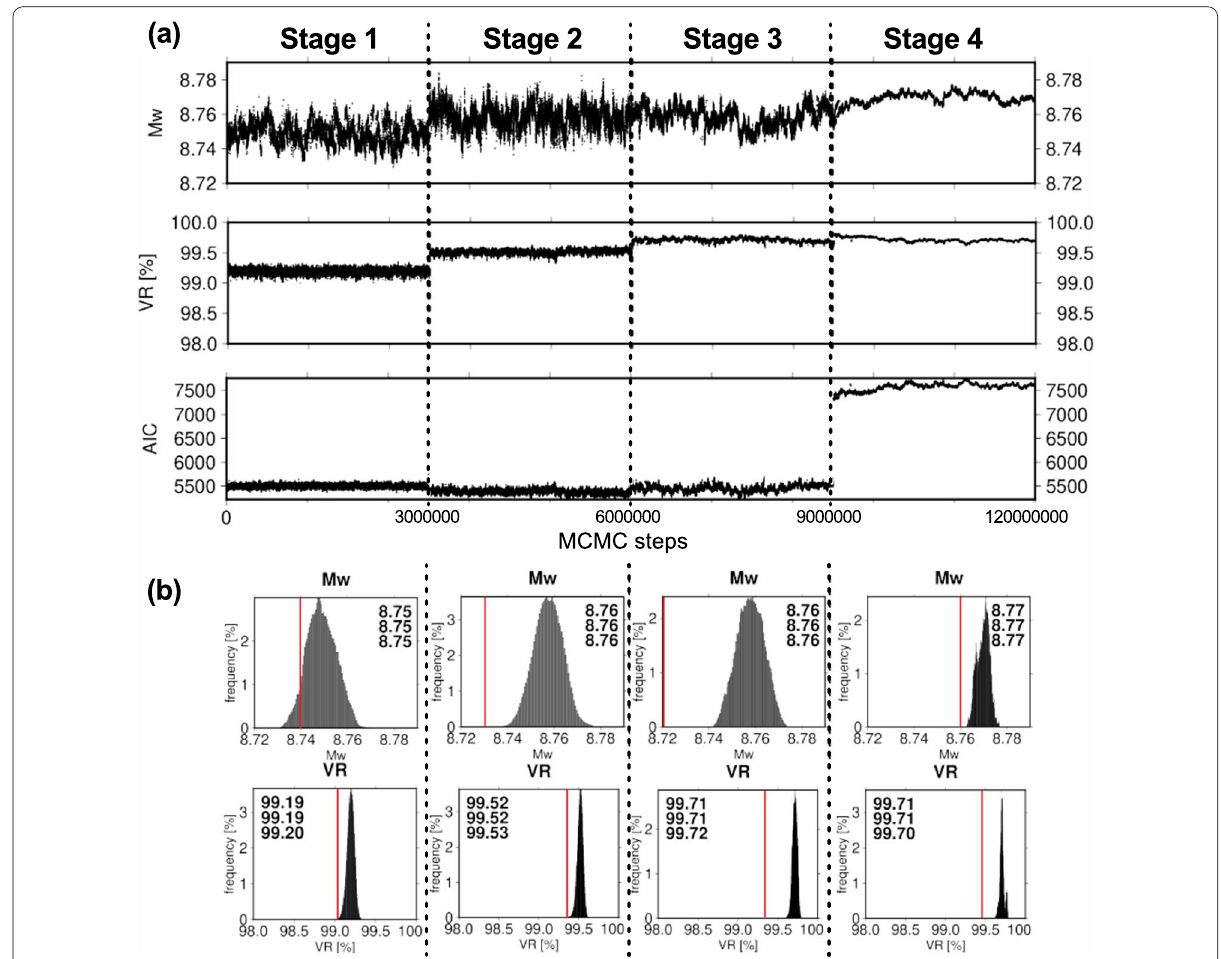
Fig. 5 Markov chains and posterior probability density functions (PDFs). We divided the Markov chain into four stages (number of steps in each chain): stage 1 ( 3 × 10 6 steps); stage 2 ( 3 × 10 6 steps); stage 3 ( 3 × 10 6 steps); and stage 4 ( 3 × 10 6 steps). a Markov chains of Mw, variance reduction (VR), and Akaike’s Information Criterion (AIC). In dotted lines, (cid:31) θ max is adjusted for 5 × 10 4 steps as burn-in, which samples are not shown in this figure. b Posterior PDFs of Mw and VR. The range on the horizontal axis is same with the range on the vertical axis of ( a ). Inserted values indicate mean, median, and mode (from top to bottom). Inserted vertical red lines indicate the Mw and VR values from the median models in Fig.